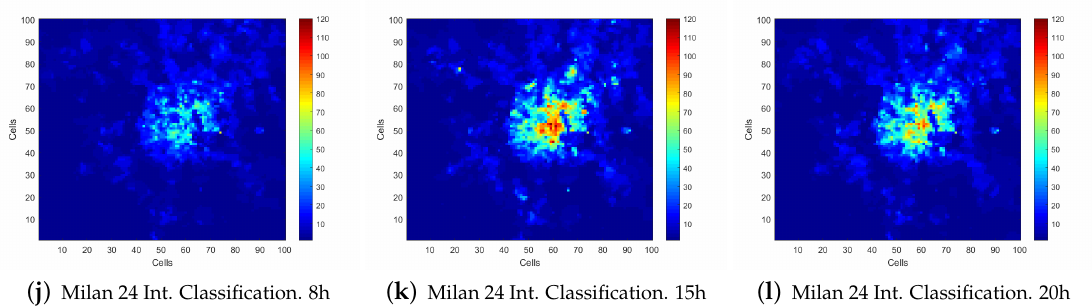
Figure 3. Heat map representation of the network usage in three different hours of the day: 8:00 h, 15:00 h, and 20:00 h. ( a – c ) The classification performed in the Trento province using the data set of one day divided into 144 intervals of 10 min. ( d – f ) The classification performed into the Trento province data set using one day divided into 24 intervals of 1 h. ( g – i ) The classification performed in one day divided into 144 intervals of 10 min using the Milan data set. ( j – l ) The classification performed to the Milan data set on the same day grouped into 24 intervals of 1 h.